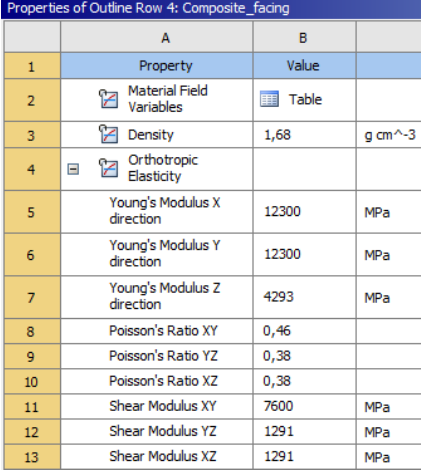
Figure 21. Input mechanical material property parameters in ANSYS environment.